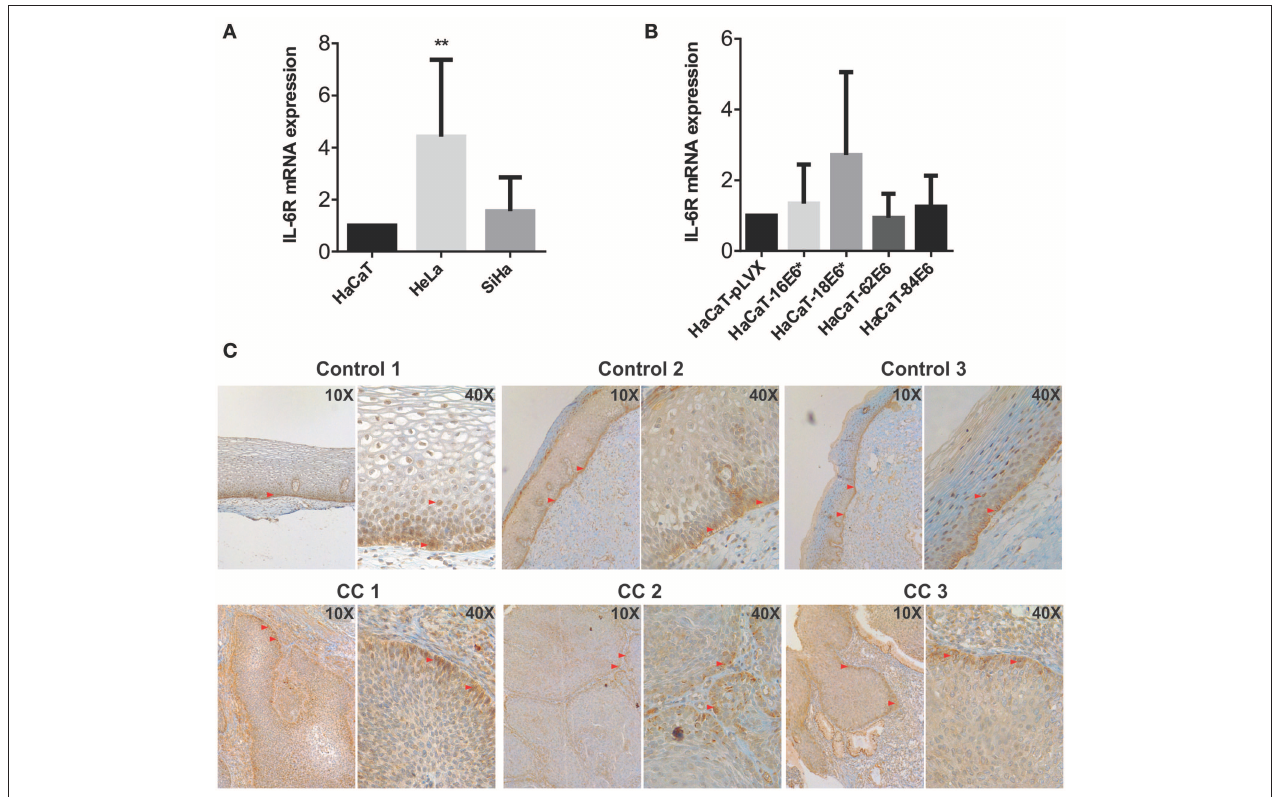
FIGURE 4 | Evaluation of IL-6R expression in cell lines and cervical tissues. (A) IL-6R mRNA expression evaluated by qPCR in HaCaT, HeLa, and SiHa cells and (B) in E6 transduced HaCaT cells using HaCaT-pLVX as calibrator. Actin and RPL32 were used as reference genes, error bars represent standard deviation and asterisks indicate statistical significance (** p < 0.01). (C) IL-6R protein expression by immunohistochemical analysis in control and cervical cancer (CC) tissues. Red arrows indicate positive signal to IL-6R.